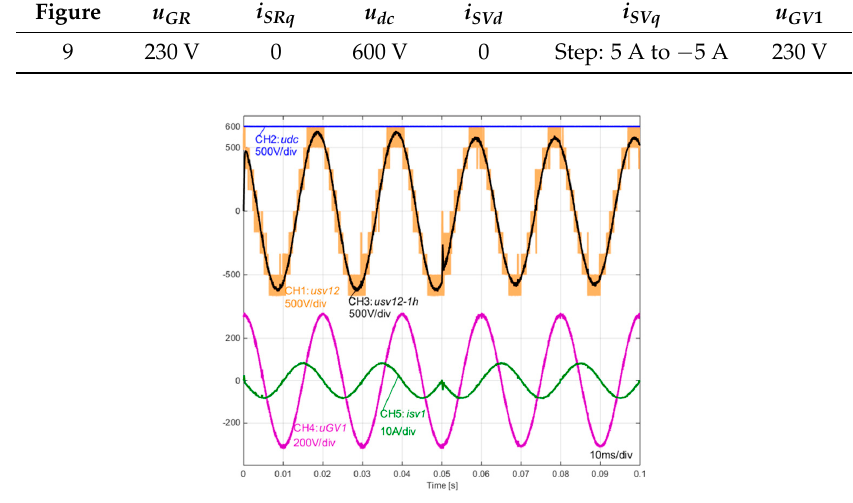
Figure 9. First harmonic of the u GV line to line voltage simulation result. CH1: u SV 12 , 500 V/div; CH2: u dc , 500 V/div; CH3: u SV 12 - 1 h , 500 V/div; CH4: u GV 1 , 200 V/div; CH5: i SV 1 , 10 A/div; 10 ms/div.